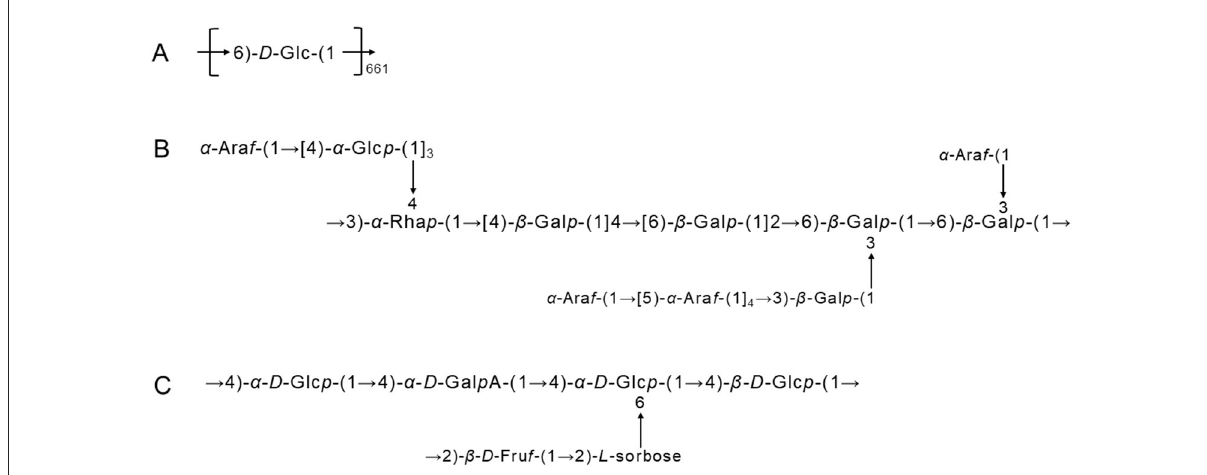
FIGURE3 The structures of longan pulp polysaccharides. (A) LPS1, (B) LPIIa, and (C) LP1.